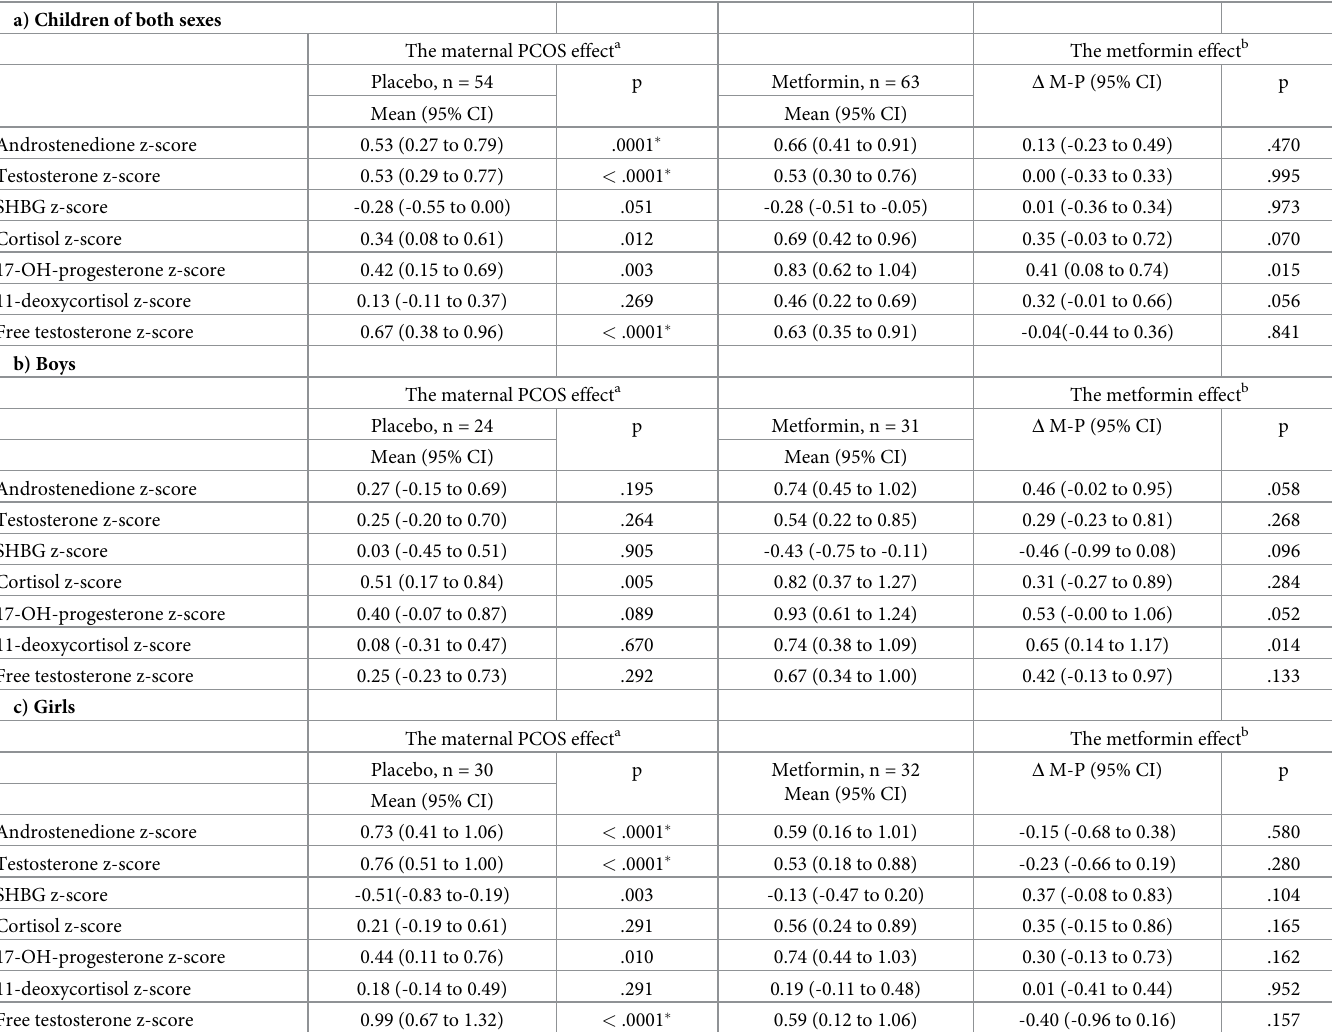
Table 2. Steroid hormone z-scores in children from the placebo and metformin